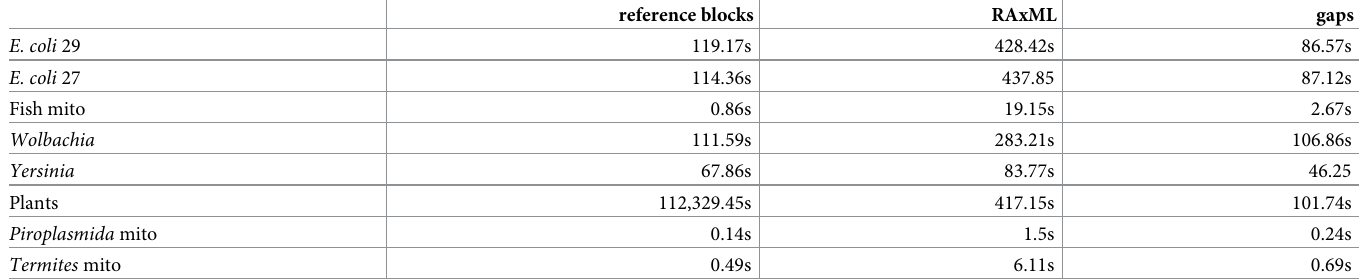
Table 4. Program runtime for the approach described in this paper, in comparison to Multi-SpaM . Column reference blocks contains the time to calculate the set of ref- erence quartet blocks with the program Multi-SpaM . Column gaps contains the remaining runtime of our method, i.e. the time to find the respective second block for each reference block. As a comparison, column RAxML contains the runtime for running RAxML on the don’t-care positions of the reference blocks